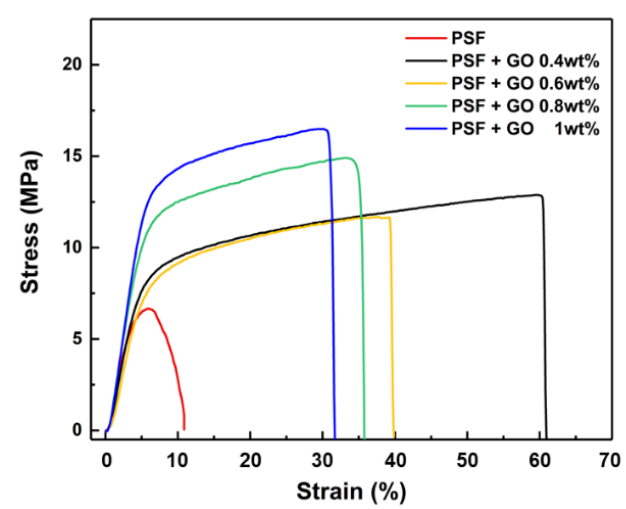
Figure 5. The tensile strength of PSF and PSF/GO membranes.